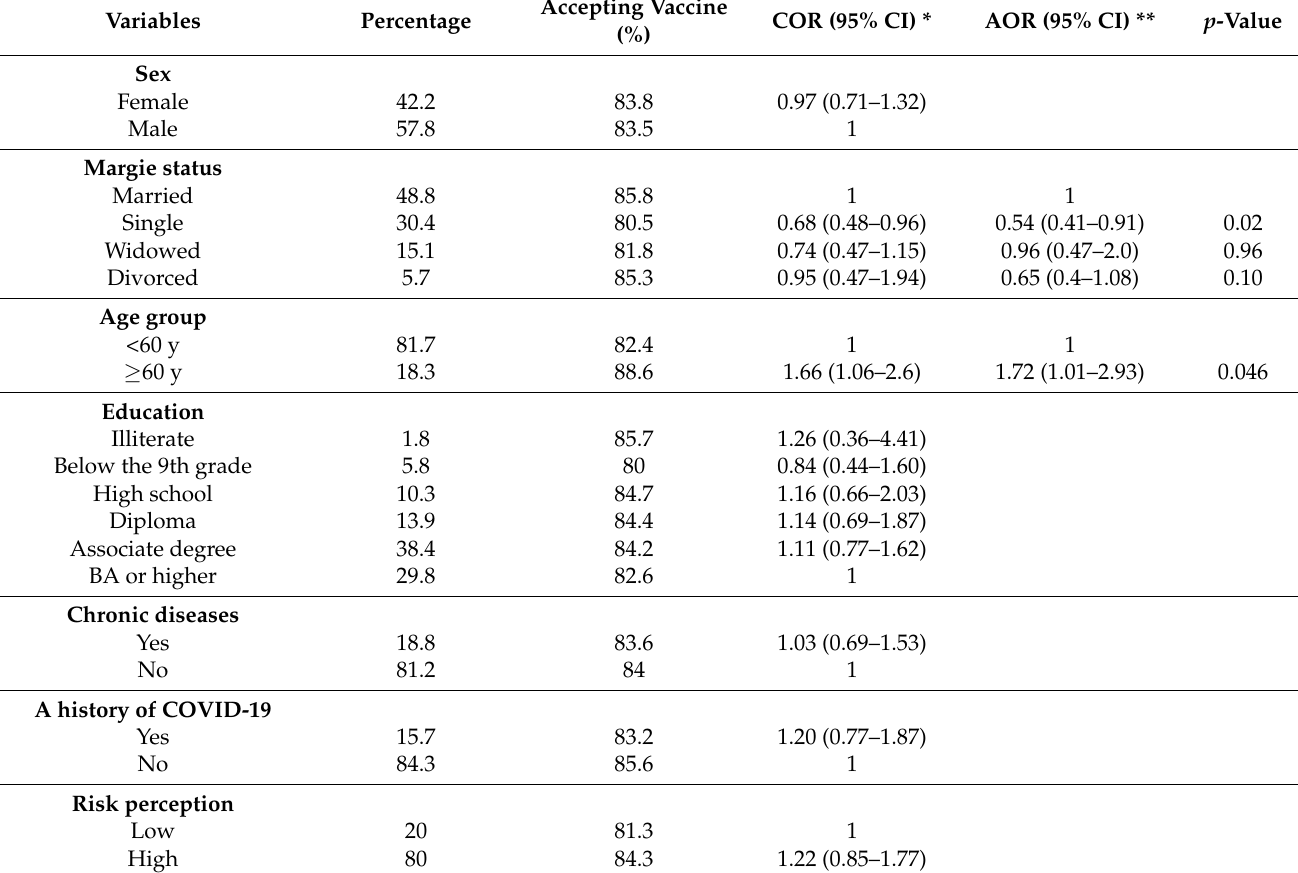
Table 2. Willingness to Receive COVID-19 Vaccine Based on Bassline Characteristics and the Results of Simple and Multiple Logistic Regression